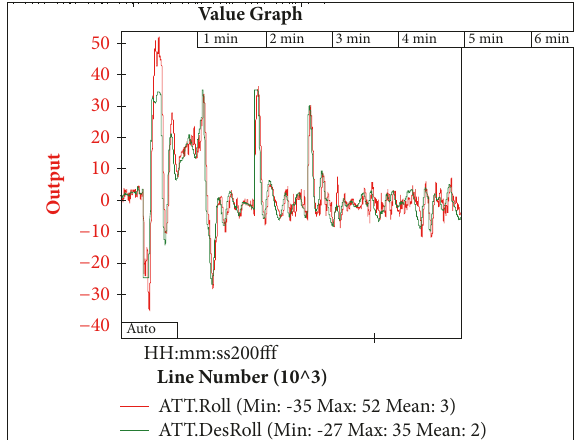
Figure 14: The roll and desired roll in experiment.